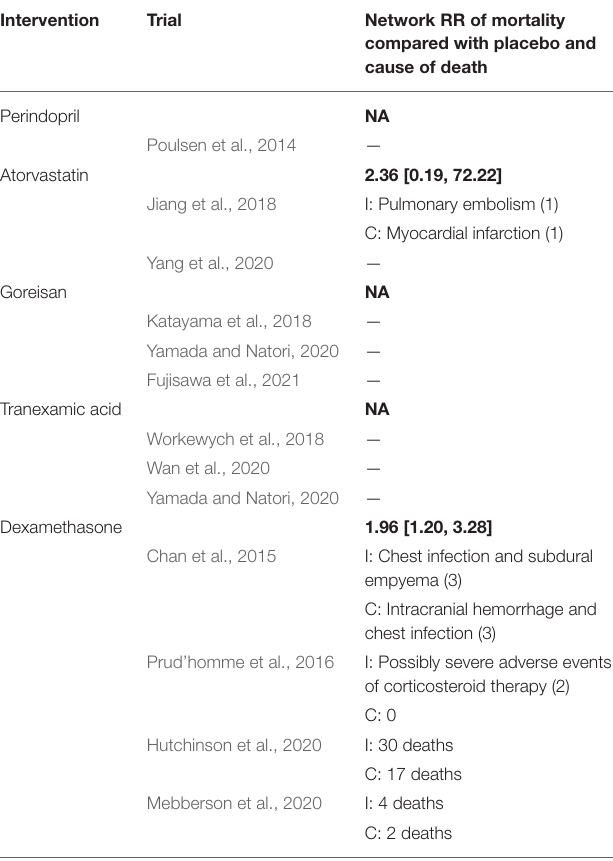
TABLE 2 | Network meta-analysis of all-cause mortality and cause of death. Intervention Trial Network RR of mortality compared with placebo and cause of